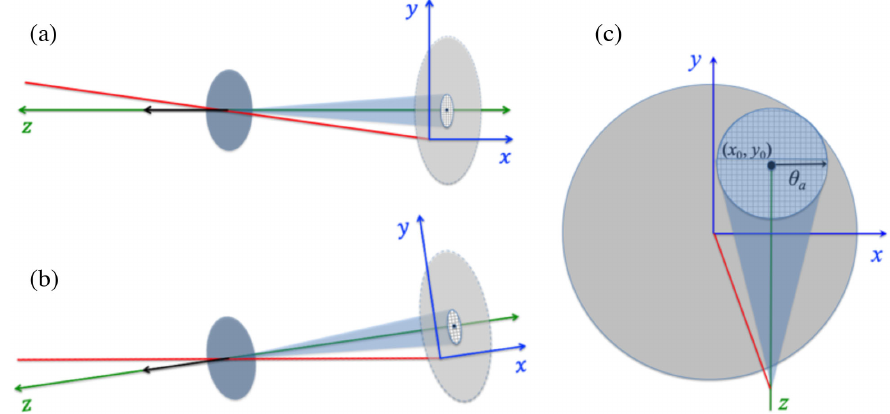
FIG. 2. Coordinate transform for SENSE code. Panel (a): Layout with the electron beam, the laser pulse (blue ellipse) and the aperture (checkered oval) all along the z -axis (green line). An electron with angles p x =p and p y =p follows the trajectory denoted by the red line. Scattered radiation computed by SENSE and collected at the aperture (here shown as circular aperture with the maximum opening of θ a , but can otherwise take on different shapes) is shown as a blue cone. Large grey circle denotes the plane which contains the aperture. The angle at which an electron passes through the laser pulse is given by the intersection of red and black lines. Panel (b): SENSE transforms the problem into a coordinate system in which each electron is aligned with the z -axis. The angle by which the aperture is offset at ( x 0 , y 0 ) is given by the intersection of red and green lines. Panel (c): Head-on view of the plane of the aperture (checkered